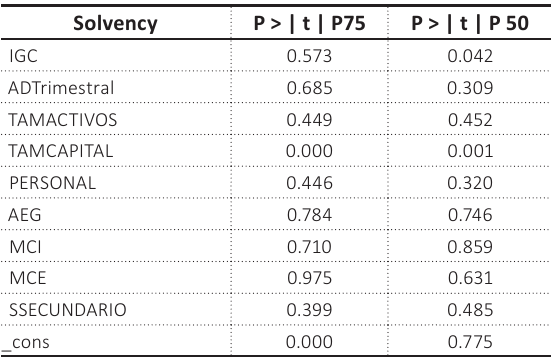
Table 9. Comparison of solvency